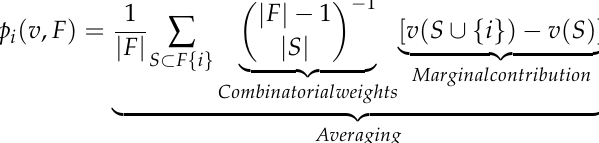
Figure 4. Warmup schedule—learning rate during training.